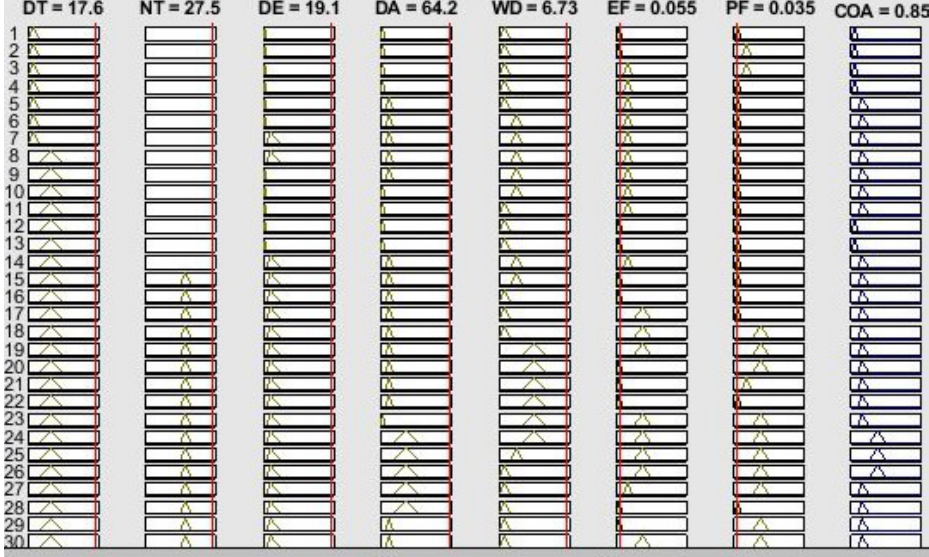
Figure 8. Testing the COA on Rule